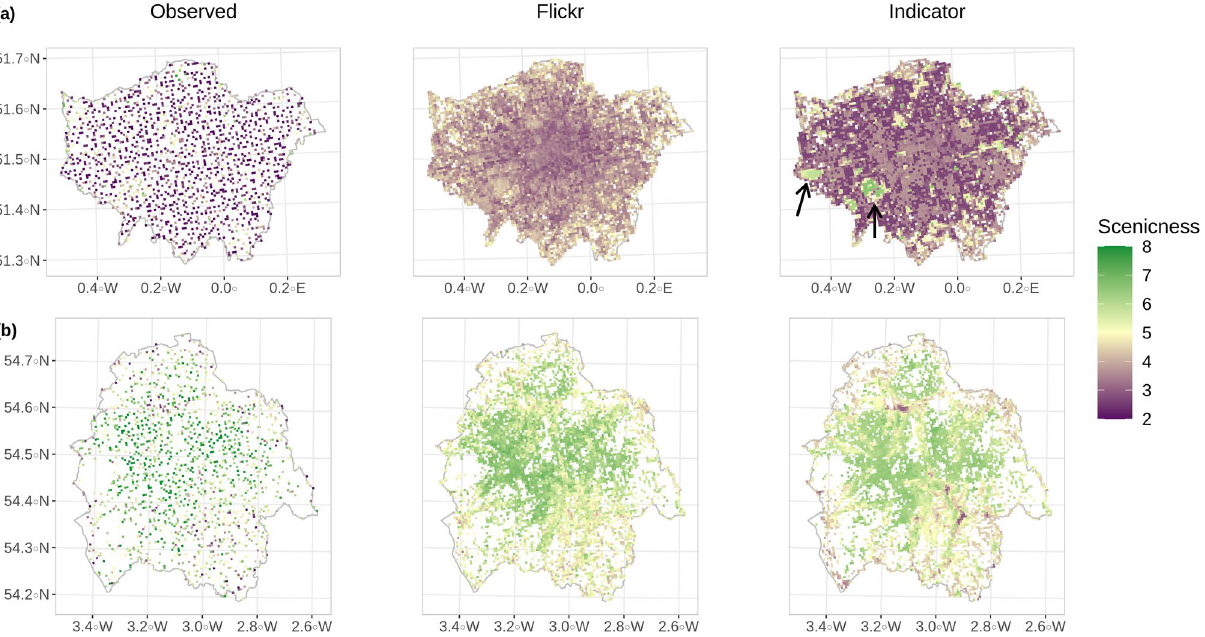
Figure 2. Observed scenicness versus the spatial predictions generated by the best-performing Flickr model and indicator model at 500 m resolution in ( a ) the Greater London area and ( b ) the Lake District national park. The arrows within the Greater London indicator model map point to Heathrow Airport (left) and Richmond Park (right). The observed versus predicted grid cell values are shown in Supplementary Fig. S1 online. Drawn using R 3.6.3 (https:// www.r- proje ct. org/) with the ggplot2 3.3.5 (https:// ggplo t2. tidyv erse. org) and cowplot 1.1.0 (https:// cran.r- proje ct. org/ packa ge= cowpl ot) packages.